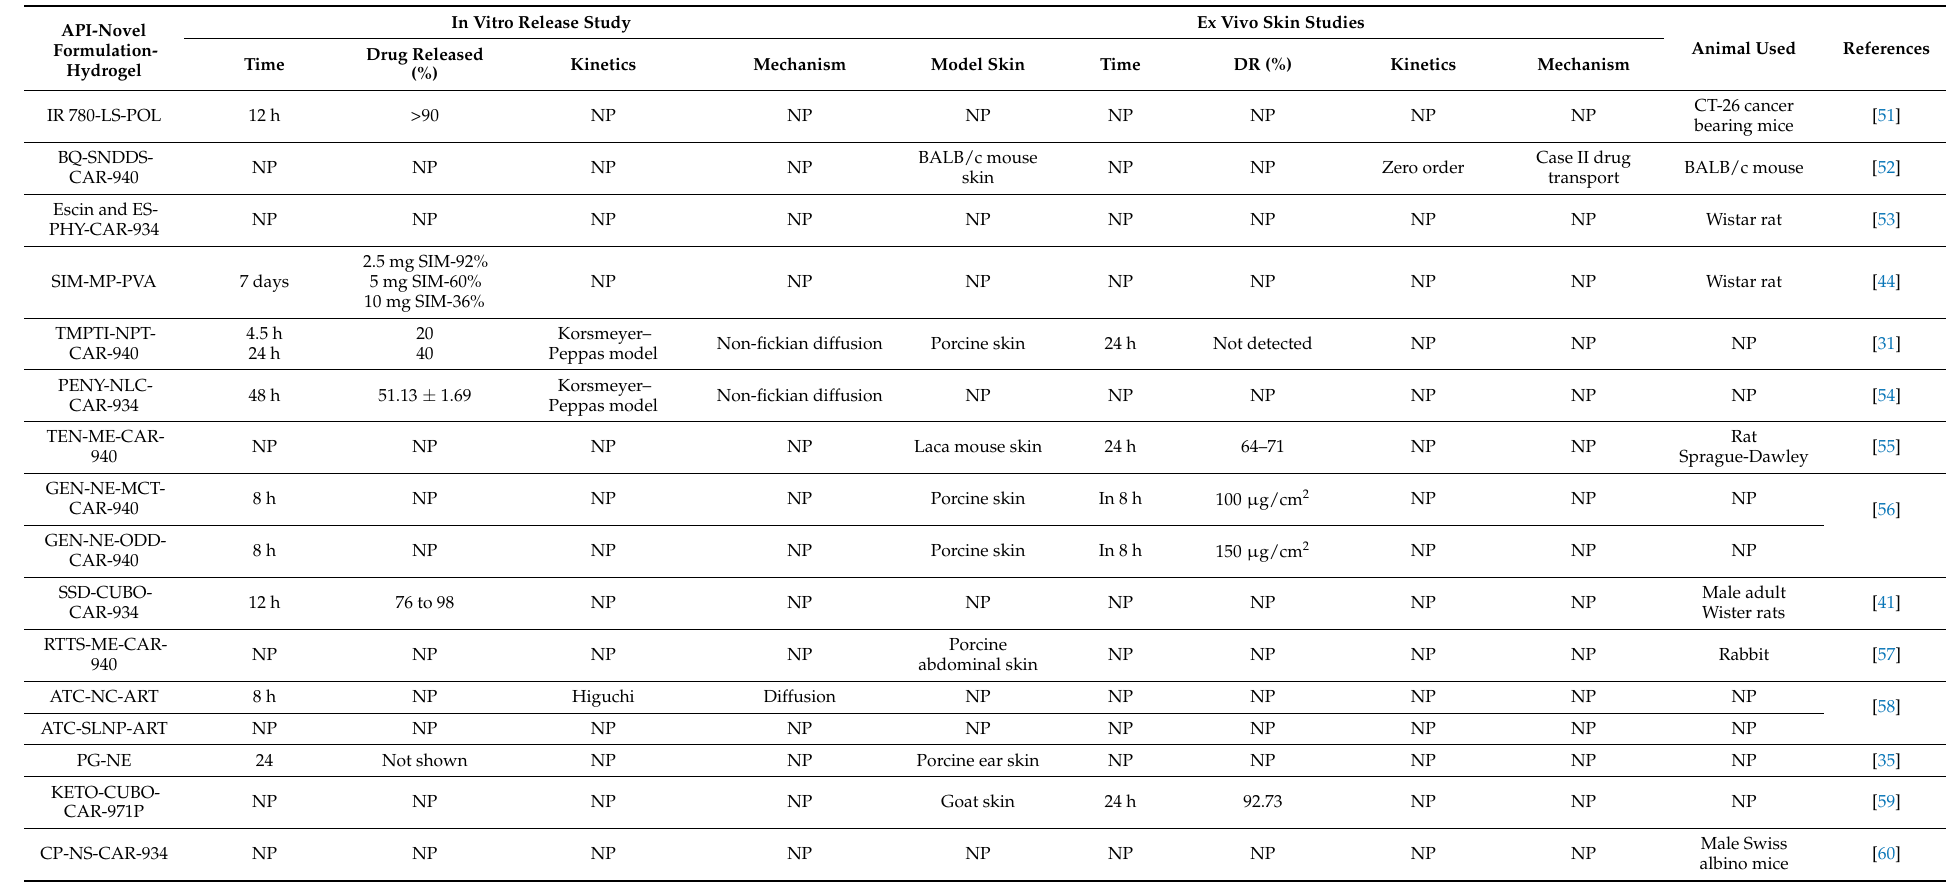
Table 8. Novel synthetic hydrogel formulation in vitro, in vivo evaluation studies